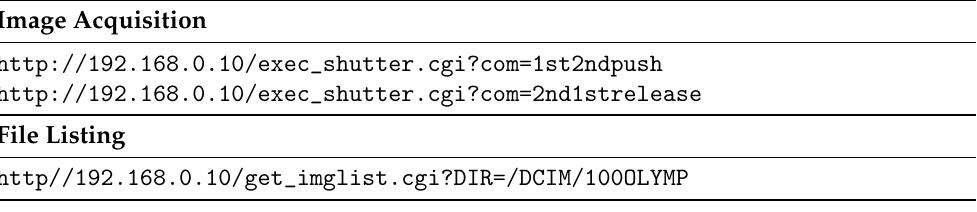
Table 1. Sensor communication command sequences.